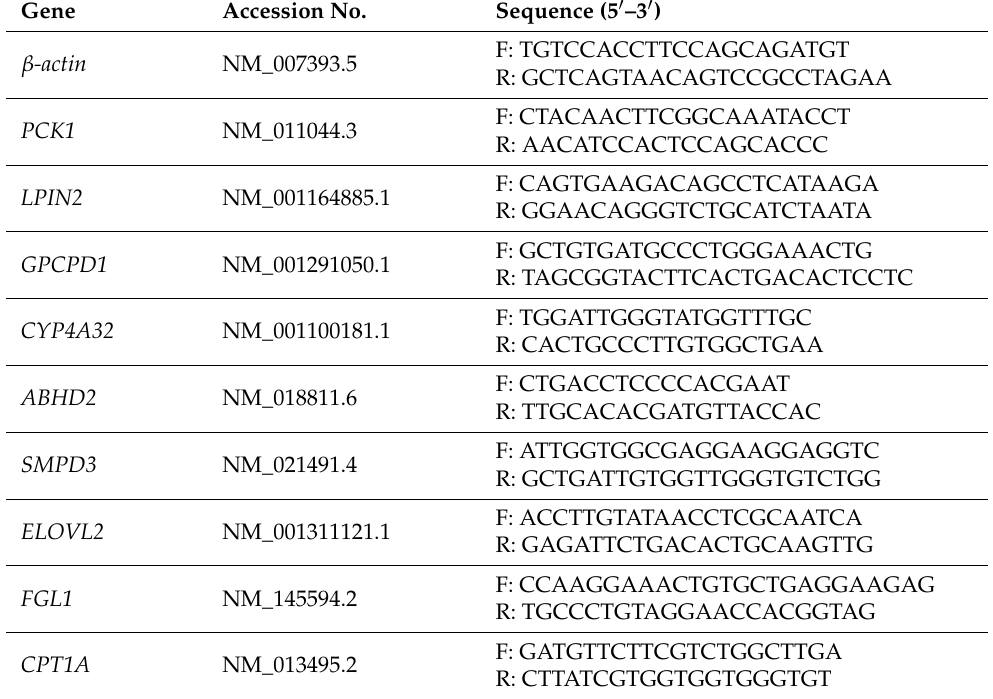
Table 1. Primers applied for qRT-PCR